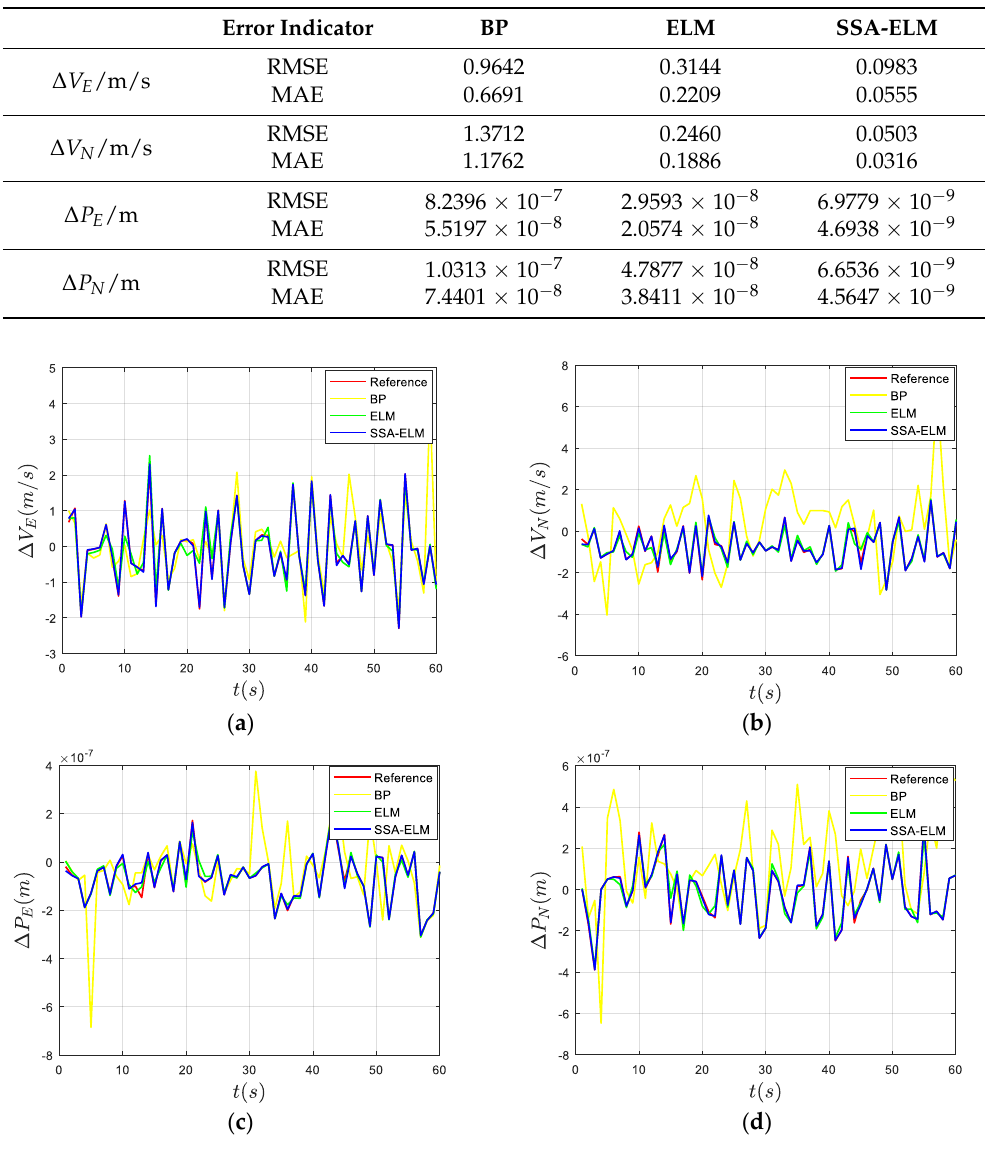
Table 8. RMSE and MAE of the velocity and position differences of different methods during the third interruption. Error Indicator